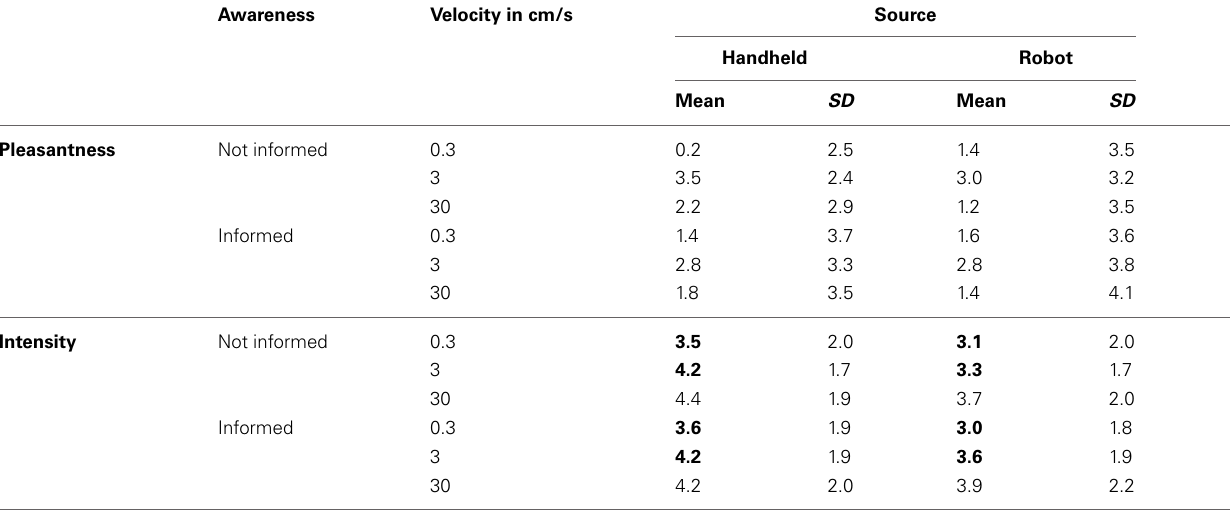
Table 3 | Mean values of the ratings generated at the different velocities and conditions.